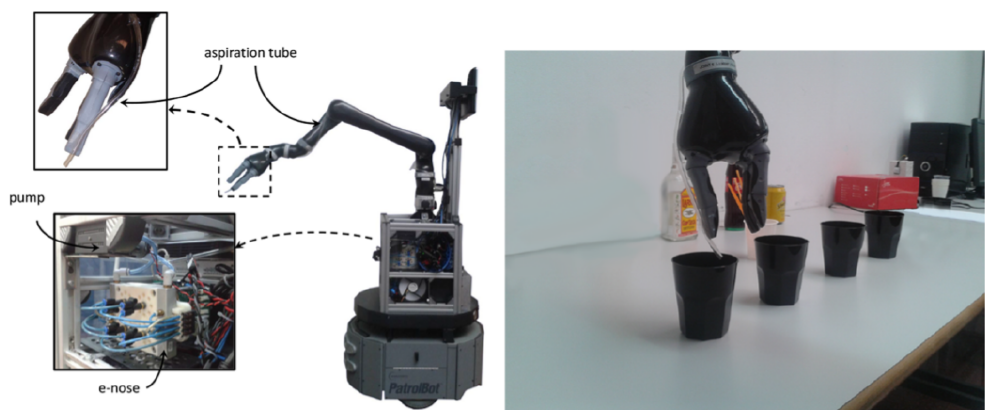
Figure 4. The Rhodon robot with the robotic arm used in the